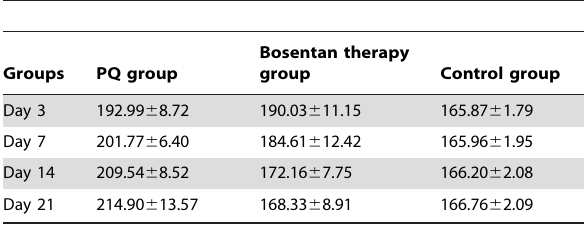
Table 3. Dynamic change of TGF- b 1 in serum from the three groups (mean 6 SD, ng/L).